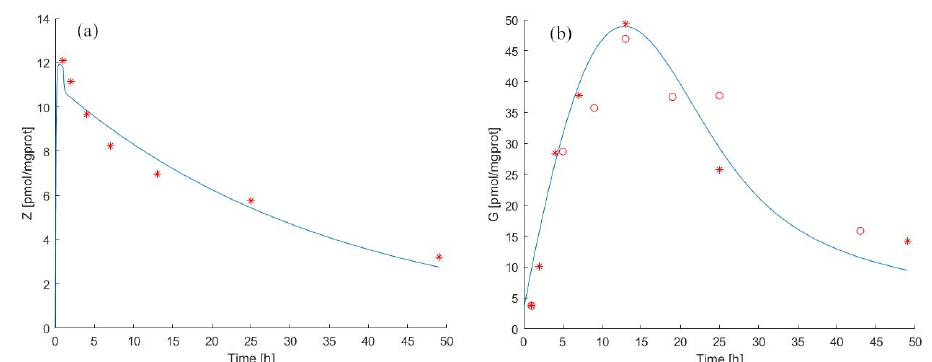
Figure 3. Model 1 simulation trend in the pulse experiment. Panel ( a ) shows the simulated zole- dronate ( ZA ) trend over time; panel ( b ) shows the simulated antigen ( IPP ) trend over time. The continuous blue line represents the model forecast, while red asterisks represent the experimental data obtained by [39] and red circles represent the experimental data obtained by